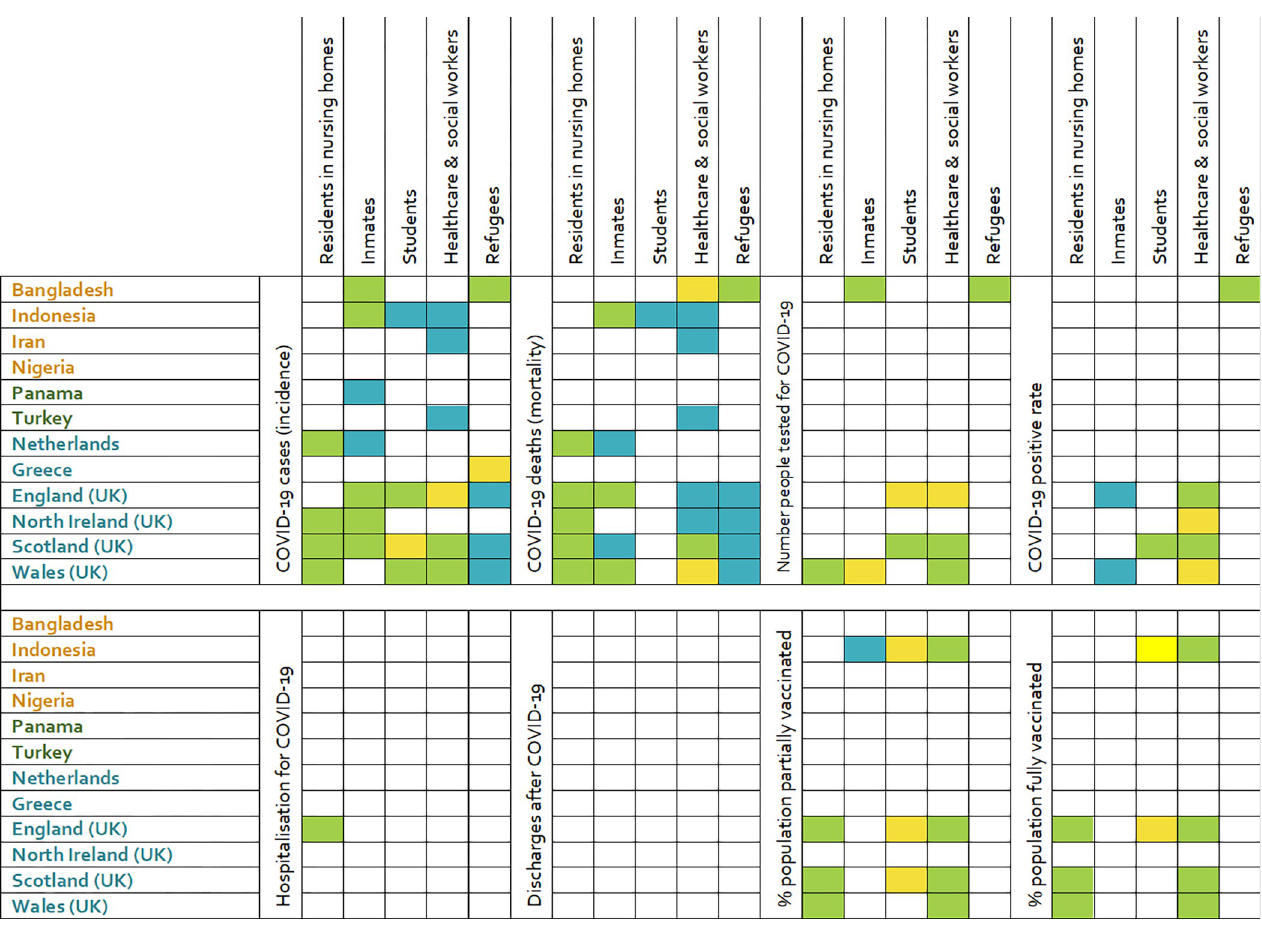
Fig 2. Heatmap illustrating the availability of data in a number of COVID-19 variables in 12 selected countries (divided into lower middle-income in orange; upper middle-income in dark green; and high income in teal) in a number of population sub-groups. Green: complete data from official source; yellow: incomplete data from official source; blue: data from unofficial